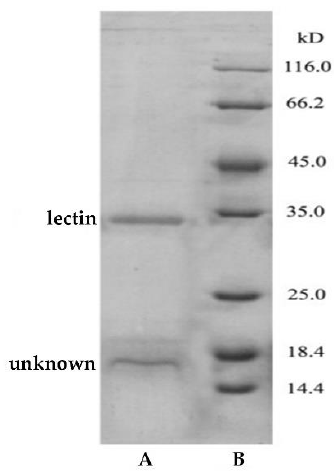
Figure 1. Gel chromatography of lectin extracted by an aqueous two-phase system (ATPS) on Sephadex G-75.